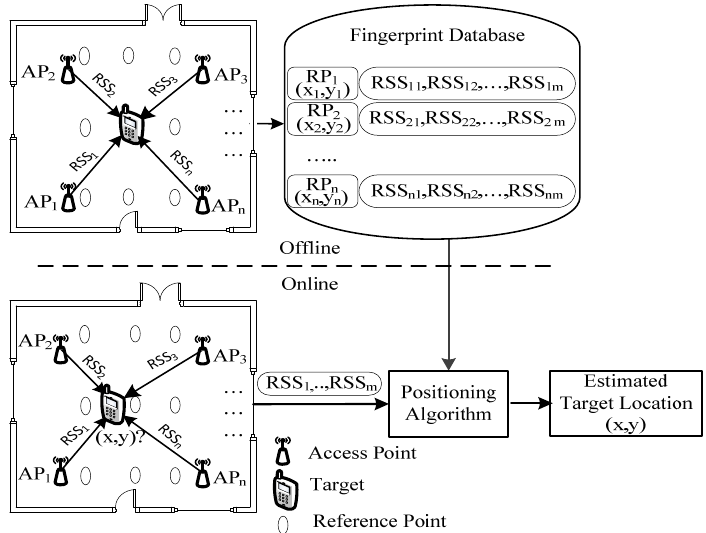
Figure 12. Fingerprinting ‐ based positioning method.